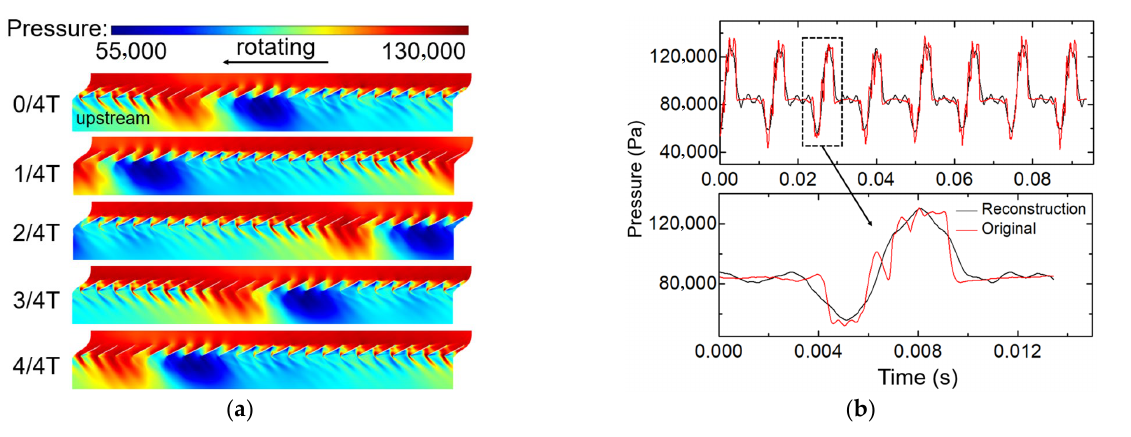
Figure 11. Flow field reconstruction results. ( a ) First 11 modes reconstruction flow field. ( b ) Pressure collected by the probe in front of the tip leading edge.